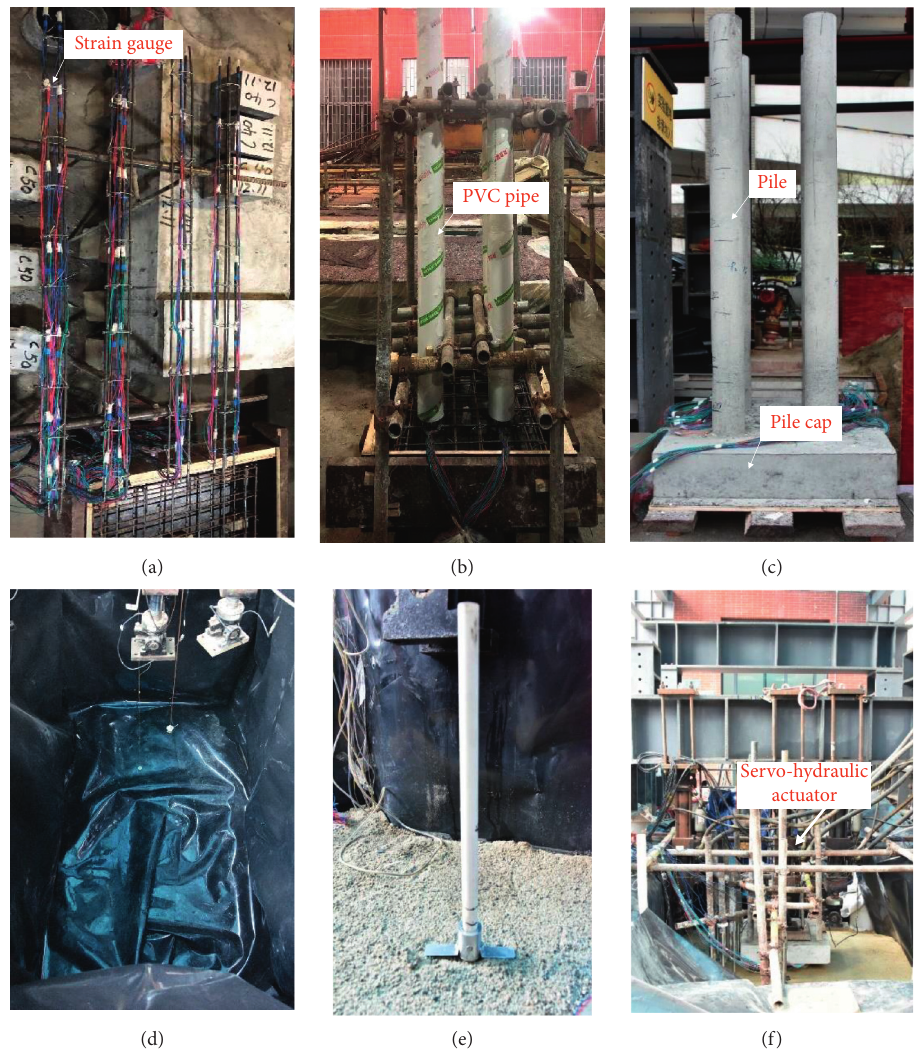
Figure 1: Test sites of model experiments. (a) Arrangement of strain gauges. (b) Casting test piles. (c) Test group piles. (d) HDPE geomembrane. (e) Layered settlement instrument. (f) Loading